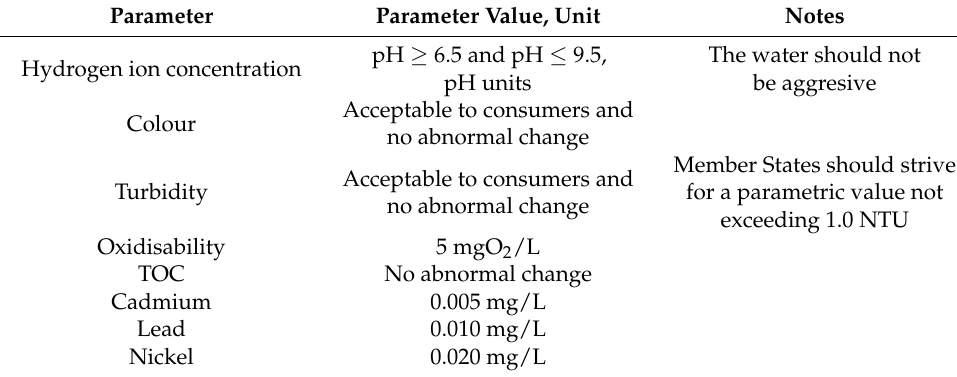
Table 2. Studied parameters values in the European Union Council Directive.